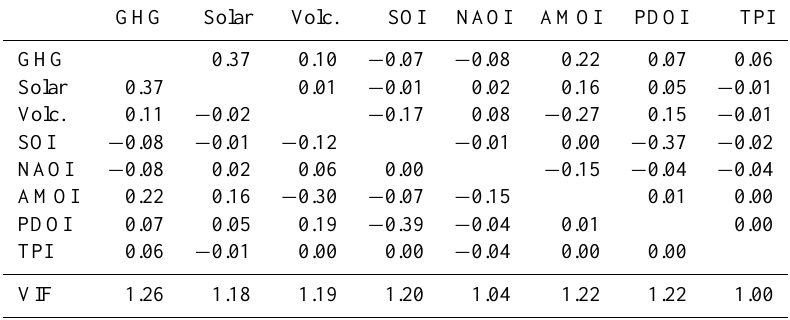
Table 1. Pearson correlation coefficient between series of individual predictors (Fig. 1) in the 1901–2010 period. The upper-right segment of the matrix contains values for the original concurrent series, the lower-left segment values for their time-shifted versions (as specified in Fig. 4’s caption). The bottom-most row shows values of the variance inflation factor (VIF) for individual time-shifted predictors, calculated as 1/(1– R 2 ), where R 2 is the coefficient of determination obtained from regression of the given explanatory variable on the rest of the predictors. See Table S1 in the Supplement for correlations over the sub-periods 1901–1955 and